Question: Summarize what this figure shows in one sentence.
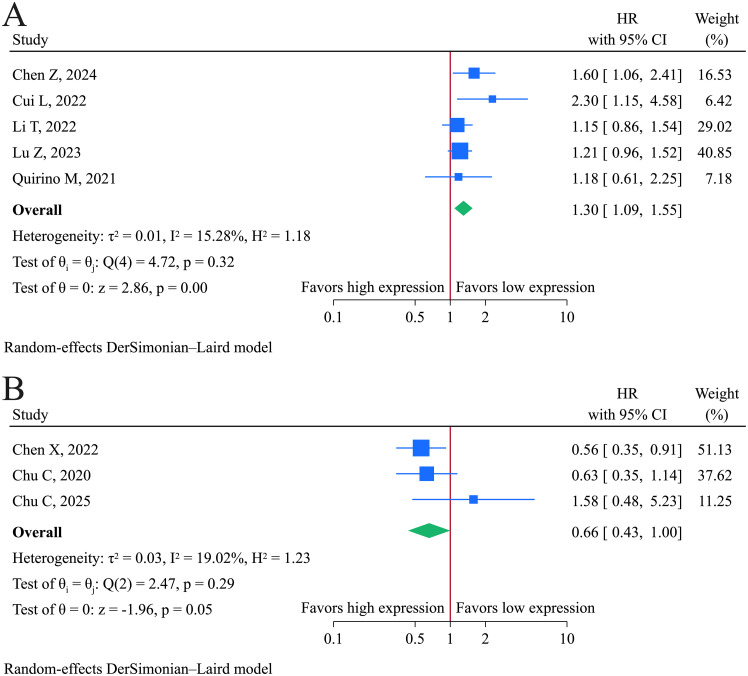
Answer: Forest plot of the association between tumoral Siglec-15 expression and DFS/RFS (A) and DSS (B) in solid tumors. DFS, disease-free survival; DSS, disease-specific survival; HR, hazard ratio; RFS, relapse-free survival.